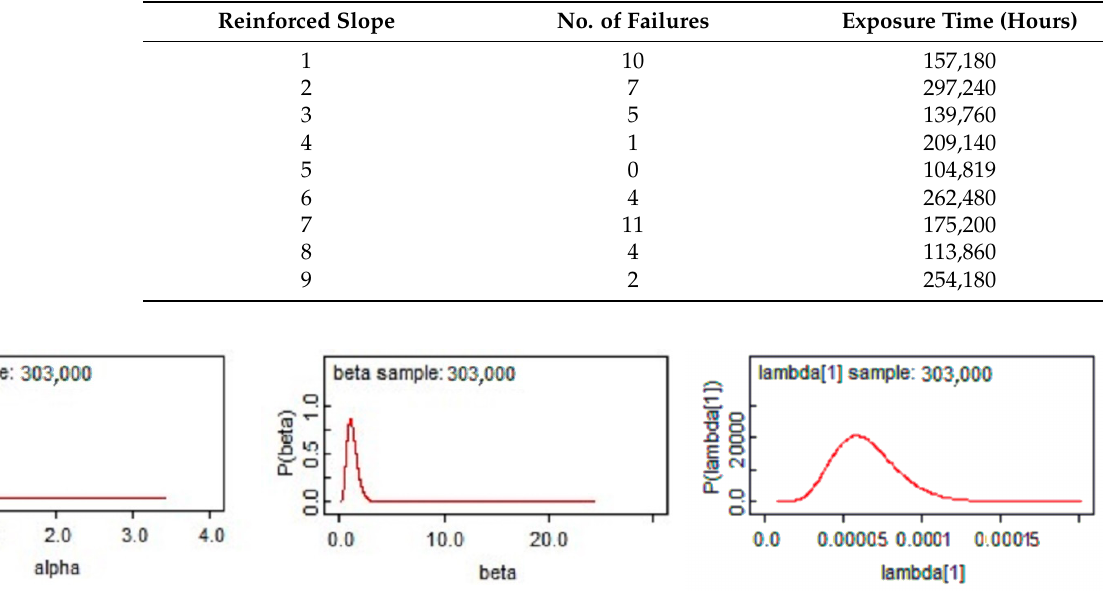
Table 1. The slope failure rates due to a poor drainage system during their lifetimes.